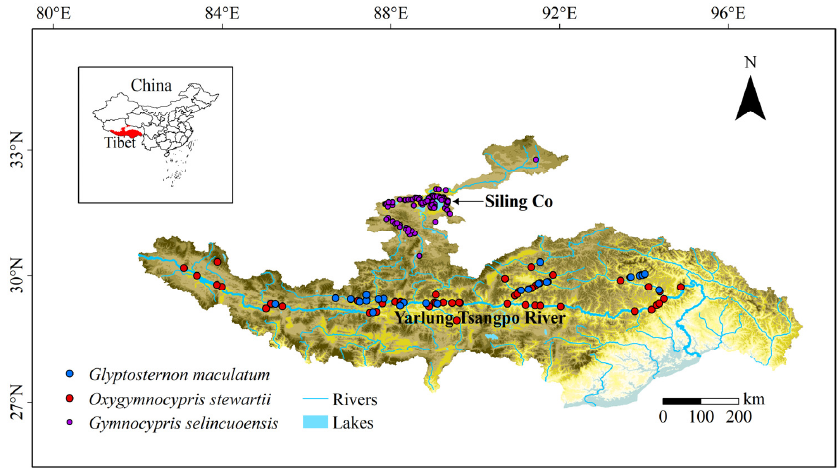
Figure 1. Species occurrences used for species distribution model.